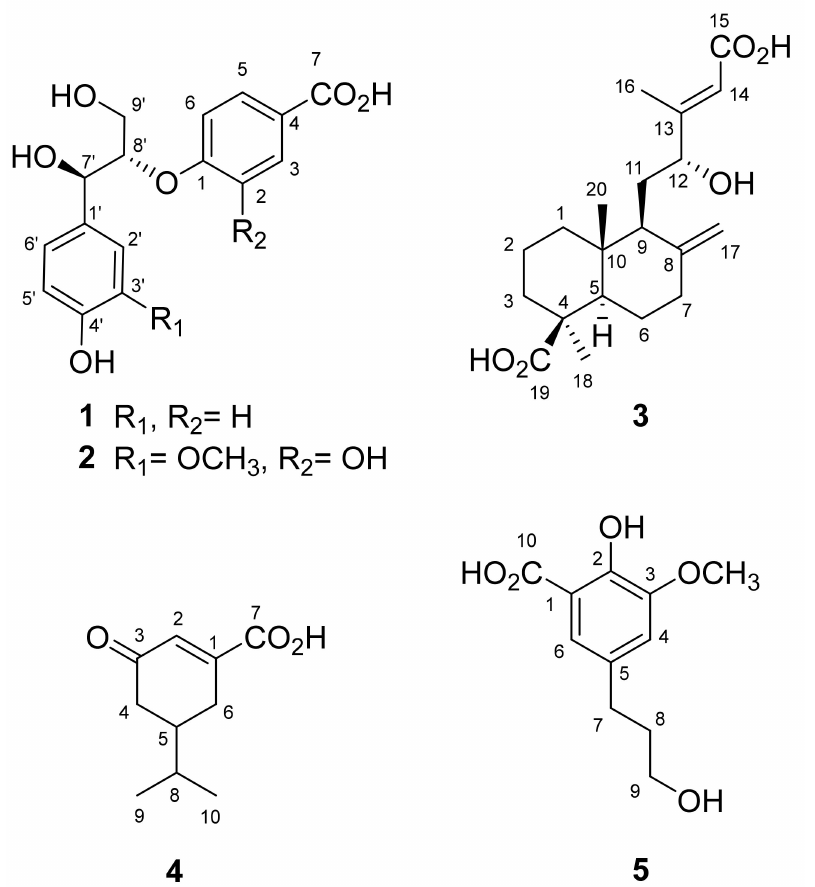
Figure 1. Structures of compounds 1 – 5 isolated from P. taiwanensis